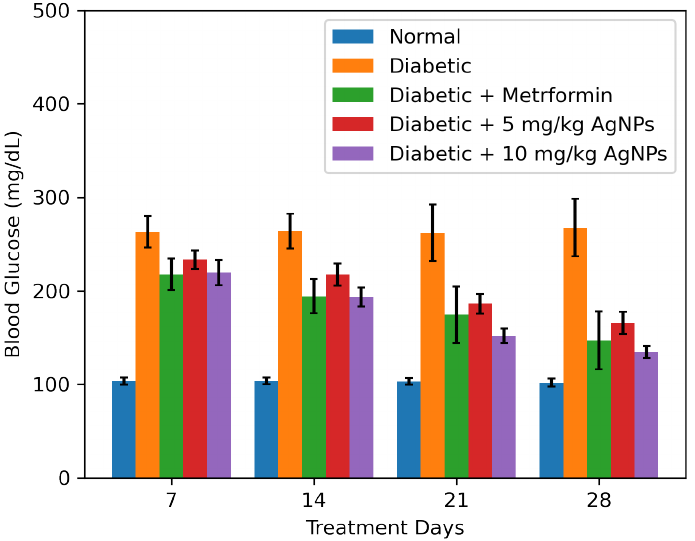
Figure 12. Histograms represent the effect of AgNPS treatment on fasting blood glucose (FBG levels (mmol/L) measured from Day 1 to Day 28 in comparison to the diabetic group. The data was analyzed using Two-way ANOVA following Bonferroni Post Hoc test and is shown as mean ±